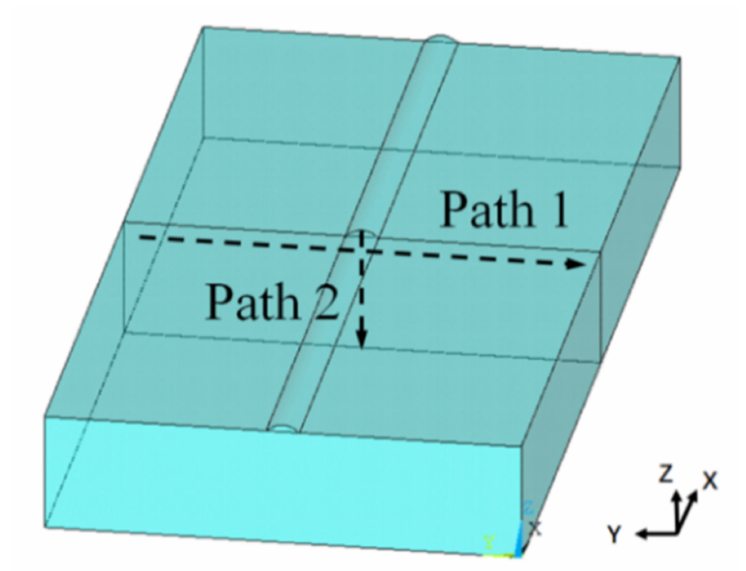
Figure 9. Path location